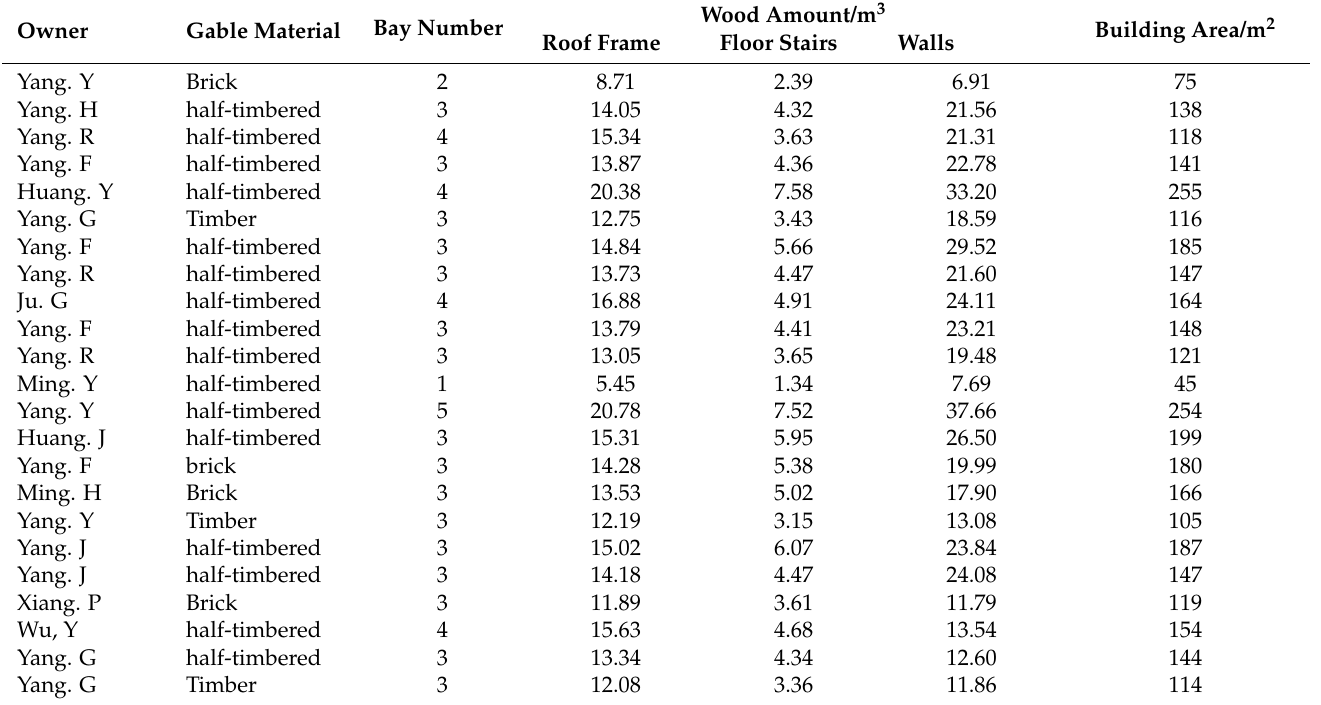
Table A1. The amount of wood used for the dwellings in High chair ancient